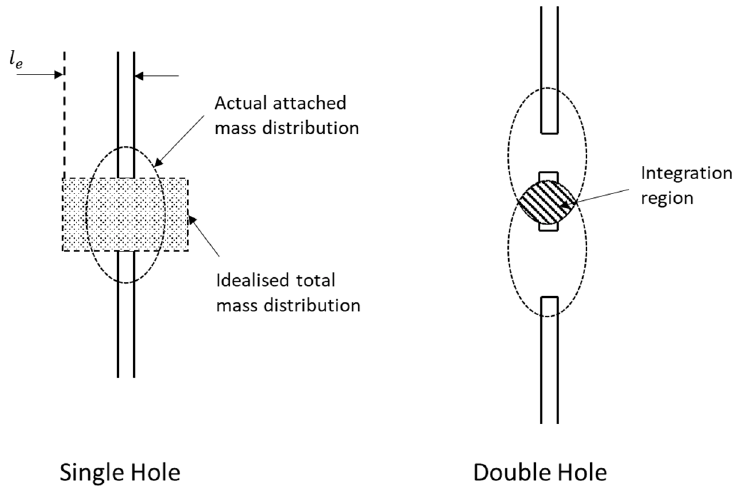
Figure 1. Fok’s function.